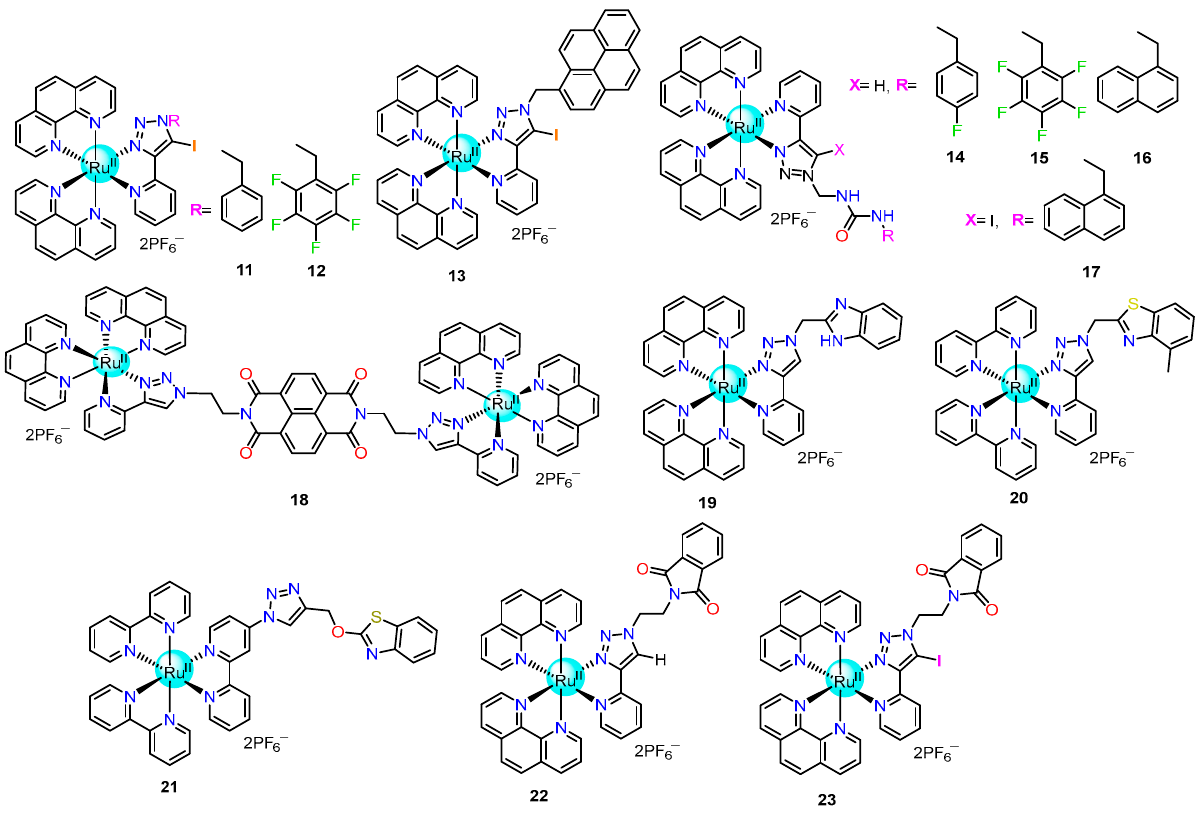
Figure 3. Structures of triazole-based Ru(II) complexes 11 – 23